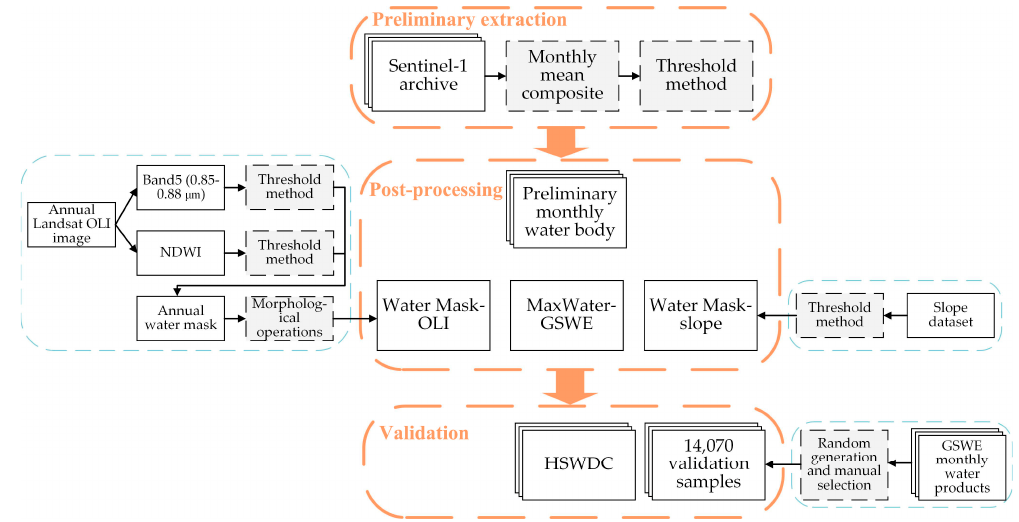
Figure 2. Flow diagram of this study.